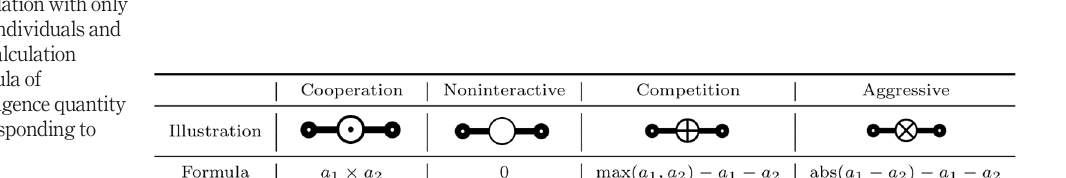
Figure 1. Graph of